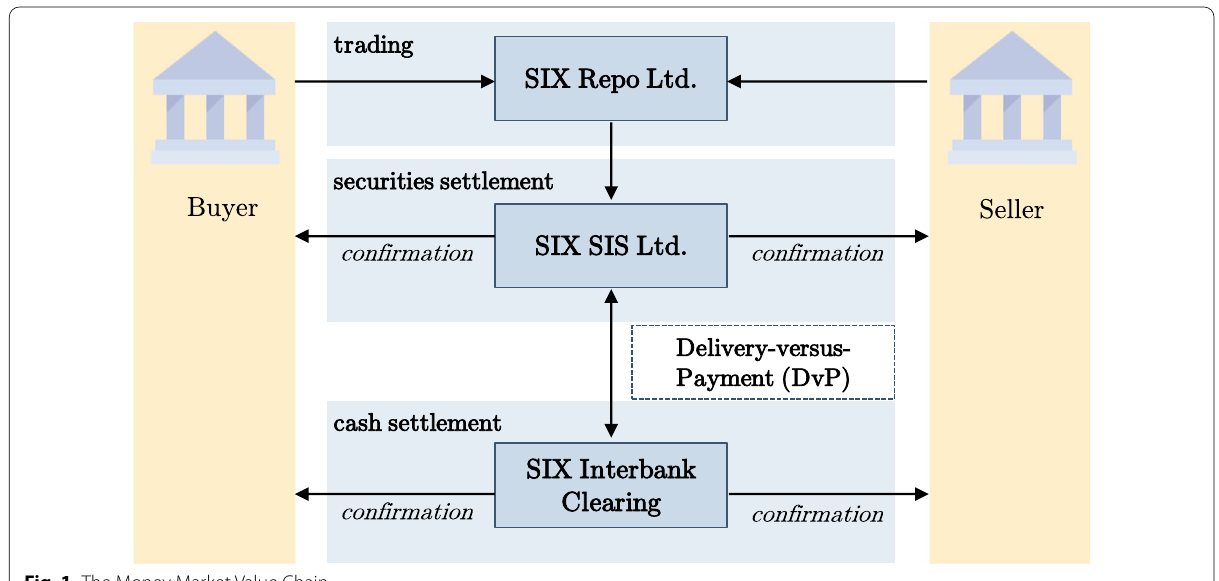
Fig. 1 The Money Market Value